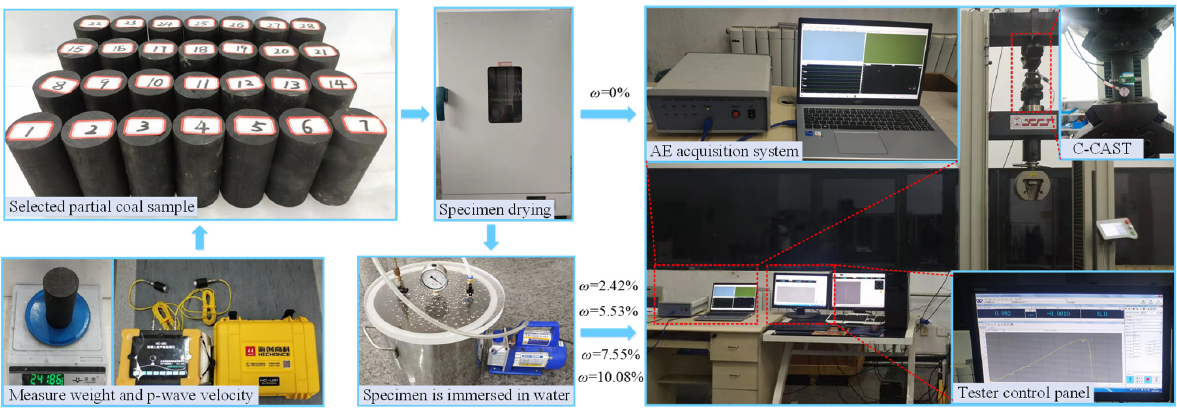
Figure 4. Test procedure and equipment.